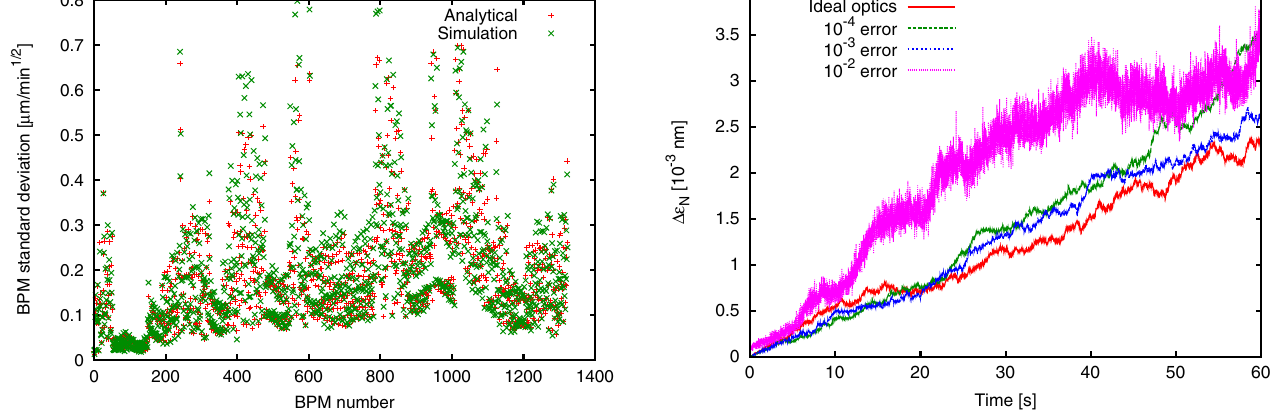
FIG. 12. (Color) Standard deviation of BPM readings for a large number of seeds. A feedback system based on 30 BPM patterns and 80 correctors is seen to control trajectory deviations reason- ably well. Simulations and analytical results agree